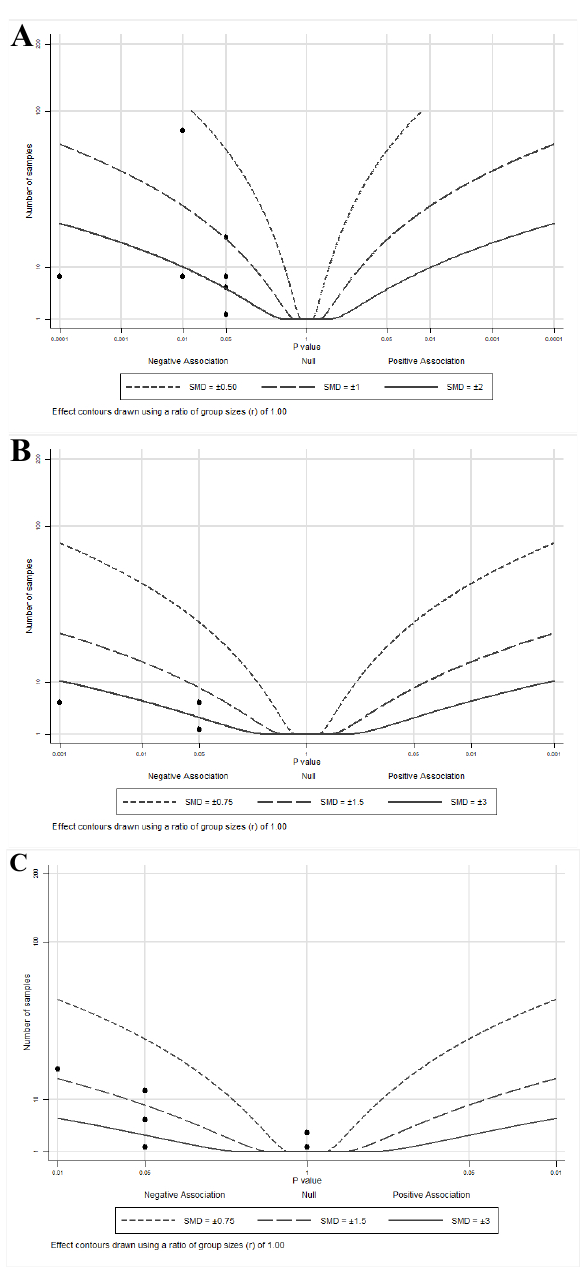
Figure 3. Albatross plots for each outcome of cell culture studies: ( A ) indirect effects (growth); ( B ) indirect effects (other); and ( C ) direct effects. Each point represents a single study, with the effect estimate (represented as a p -value), plotted against the total given sample size ( n ) included within each study. Contour lines are standardized mean differences (SMD). p -values reported as <0.05 were plotted as 0.05 as a conservative estimate, while non-significant (null) p -values were plotted as